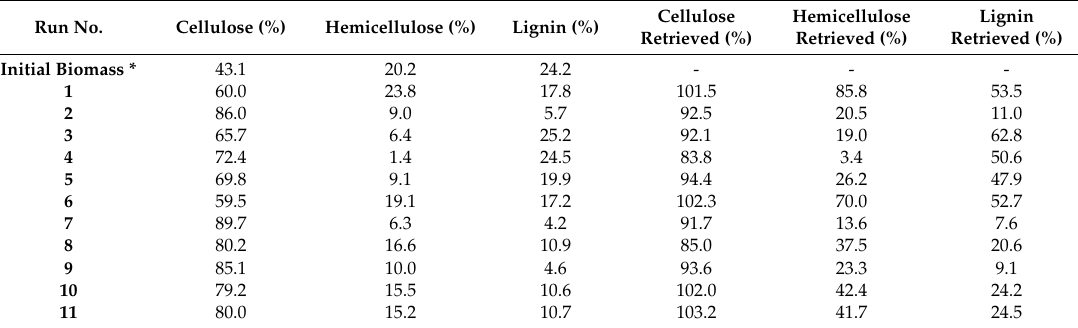
Table 2. Biomass constituents pulp content and % retrieved in the solid